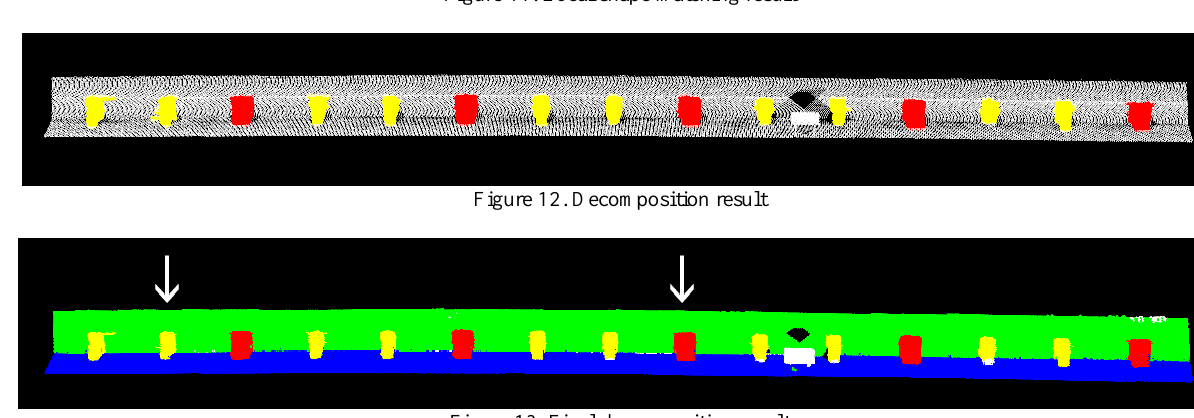
Figure 11. Local shape matching result